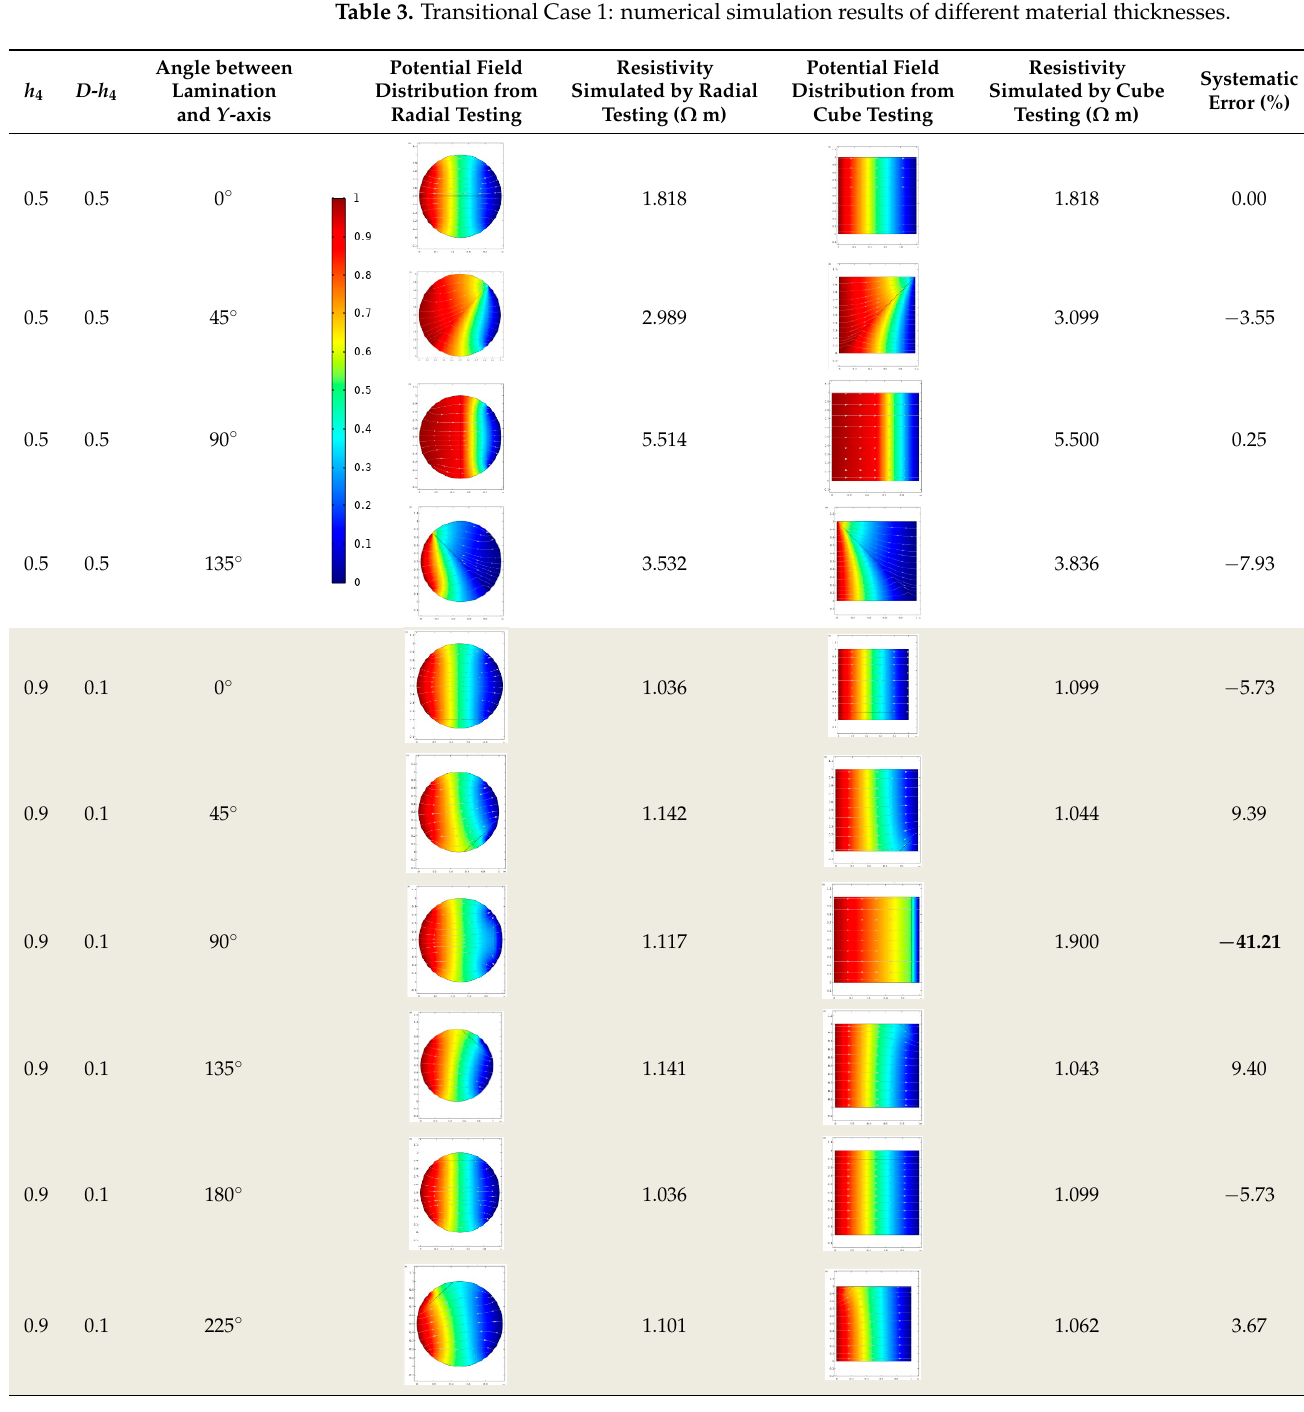
Table 3. Transitional Case 1: numerical simulation results of different material thicknesses.